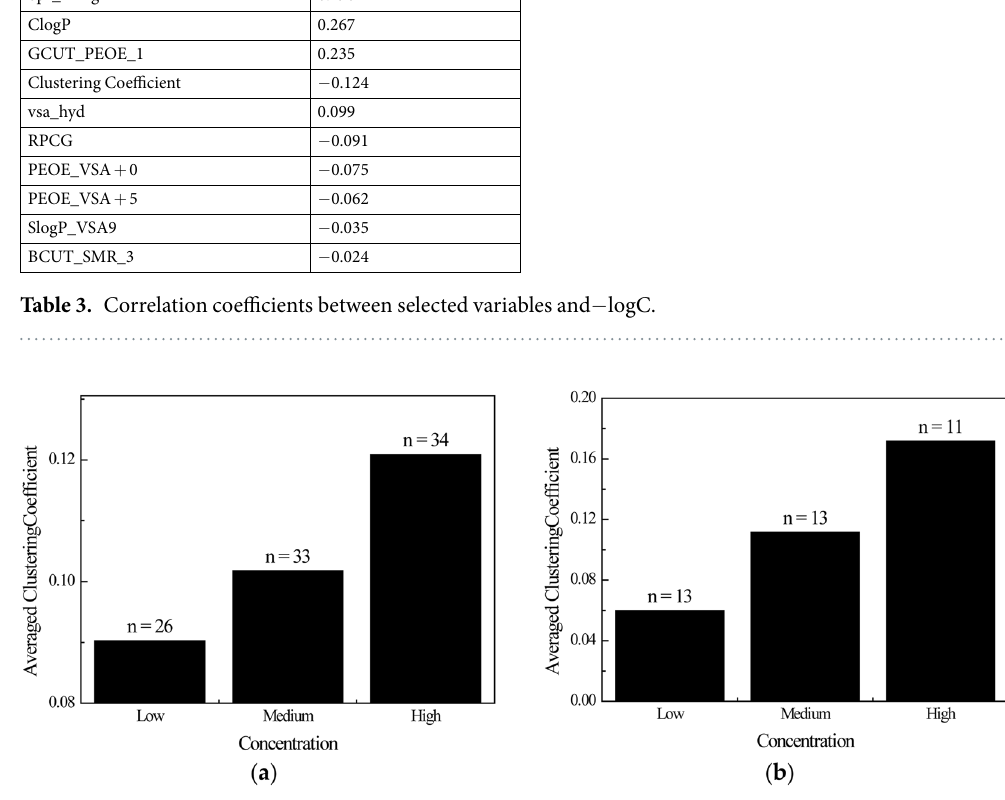
Figure 1. Correlation between metabolite concentration and Clustering-Coefficient in ( a ) E. coli ; and ( b ) S. cerevisiae